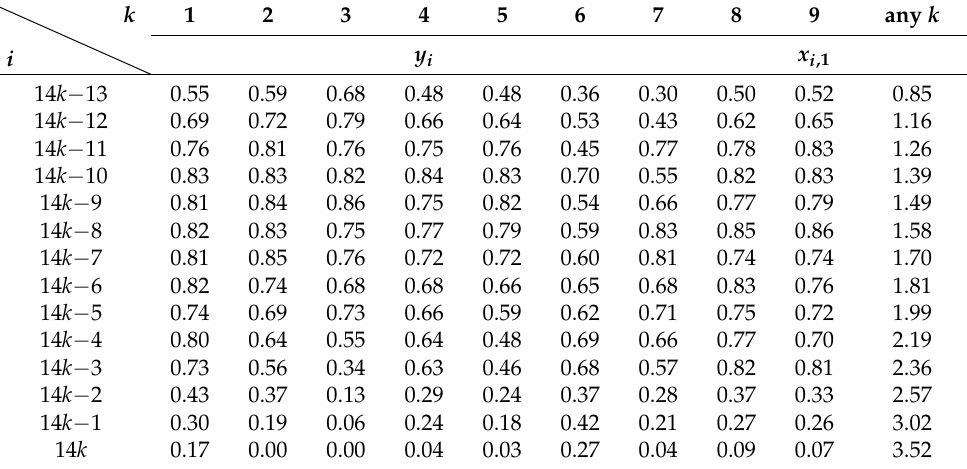
Table 2. Values of the measured hydrodynamic efficiencies, y i , and of unitless wavenumbers x i, 1 = K , where the number of the group is k = 1,2, . . . ,